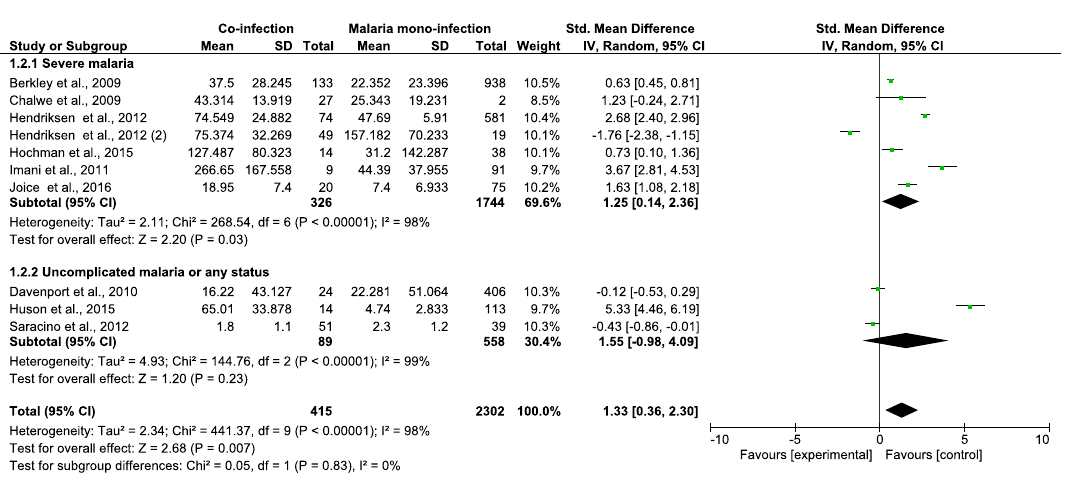
Figure 4. The pooled MD of parasite density between Plasmodium spp. and HIV co-infected and Plasmodium spp.